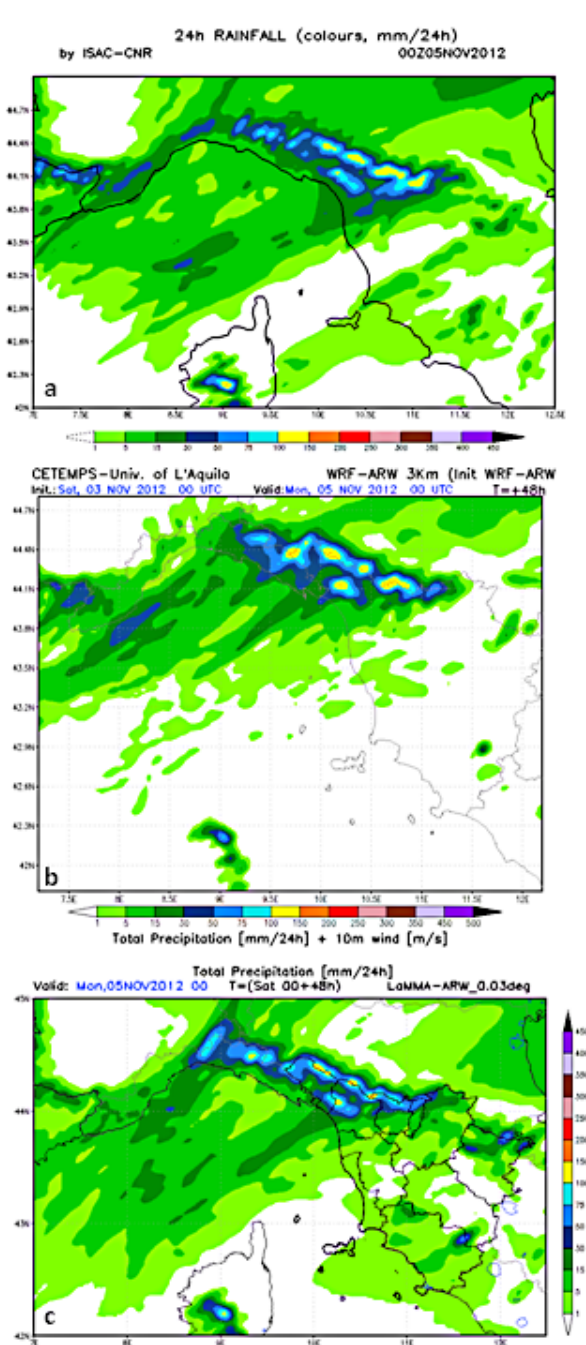
Figure 25. 24h accumulated precipitation forecast by different op- erational chains using WRF-ARW: (a) CNR-ISAC at 3km start- ing at 00:00UTC, 3 November; (b) CETEMPS at 3km start- ing at 00:00UTC, 3 November; (c) LAMMA at 3km starting at 00:00UTC, 3 November.